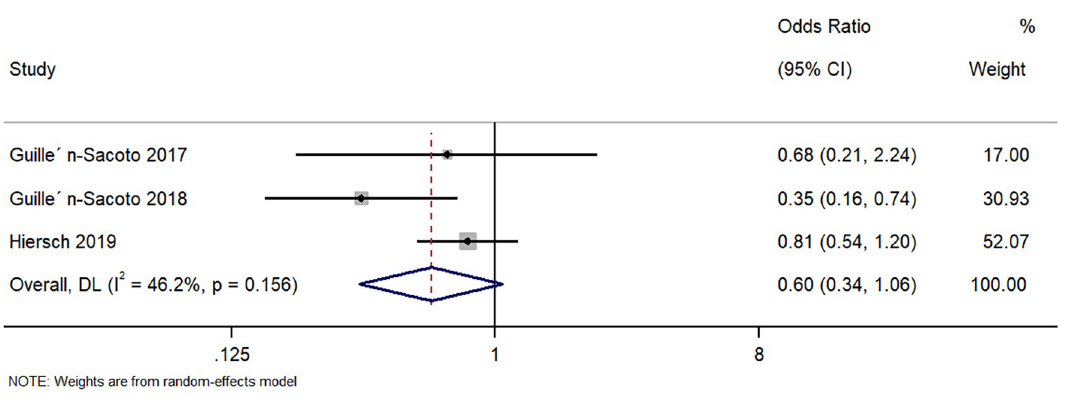
Fig 2. Forest plot showing the difference in gestational hypertension between women with a singleton pregnancy or twin pregnancy and GDM. NOTE: Weights are from random-effects model.